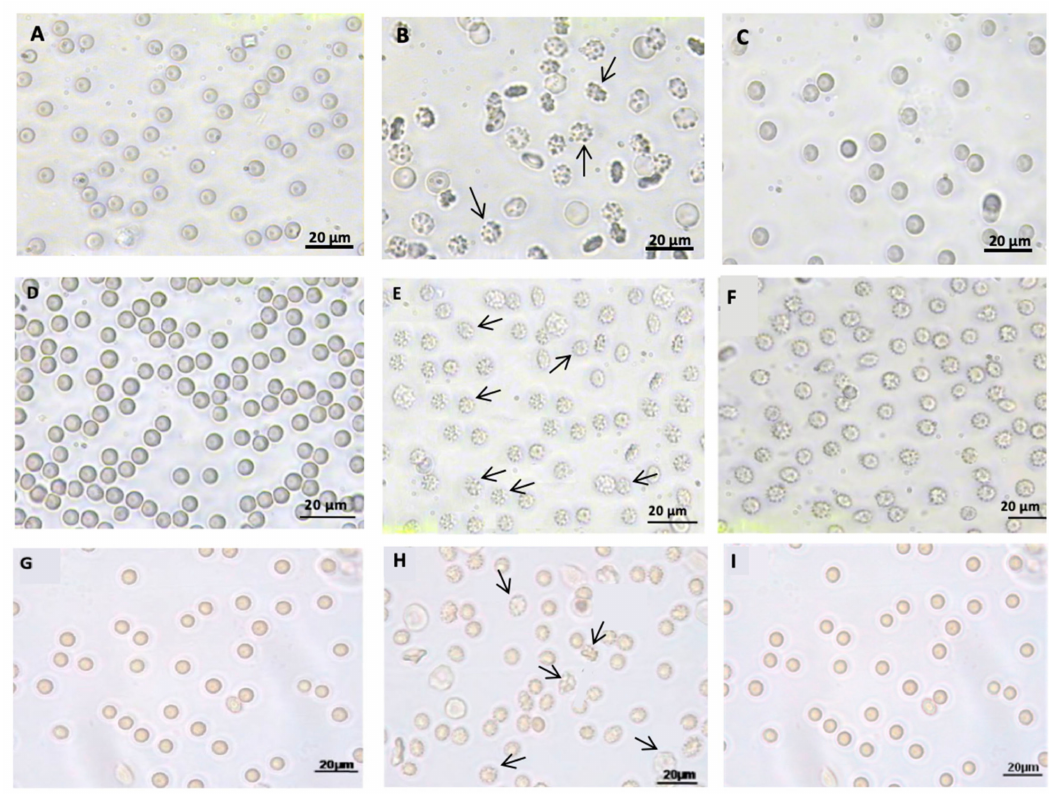
Figure 2. Light microscope observations of untreated human red blood cells [8,34,37,40,41] ( A , D , G ), or exposed to either pH 6.5 SO 4 = medium ( B ) or to pH 6.5 SO 4 = medium plus 10 µ M curcumin [34] ( C ); human erythrocytes exposed to either 300 µ M H 2 O 2 ( E ), or exposed to 10–300 µ M H 2 O 2 (pre-conditioning) [37] ( F ) in SO 4 = medium incubation; human erythrocytes exposed to either 300 = medium incubation. µ M H µ M H 2 O 2 ( H ), or exposed to 100 Melatonin plus 300 2 O 2 [40] ( I ) in SO 4 400 × magnification. Arrows indicate erythrocytes morphological alterations. Red blood cells shape is irregular due to spines, if compared to the untreated erythrocytes. Pictures are modified from references cited